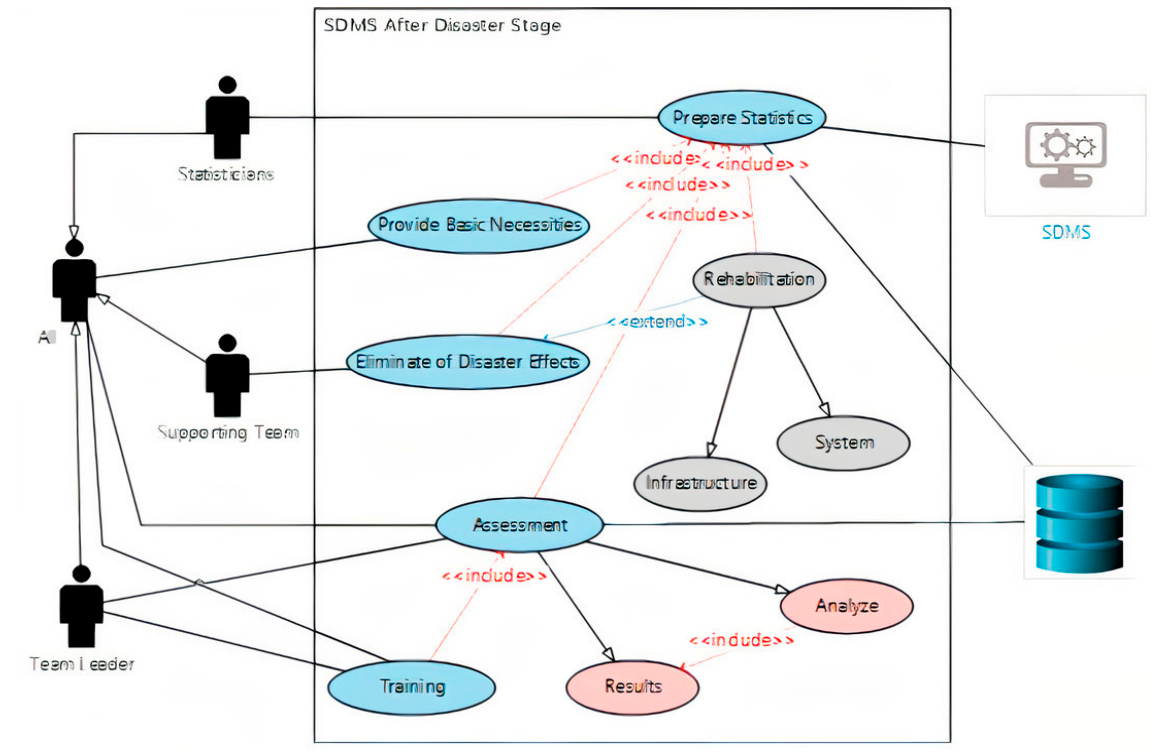
Figure 5 . Use case diagram of after flood disaster stage [39]. Figure 5. Use case diagram of after flood disaster stage